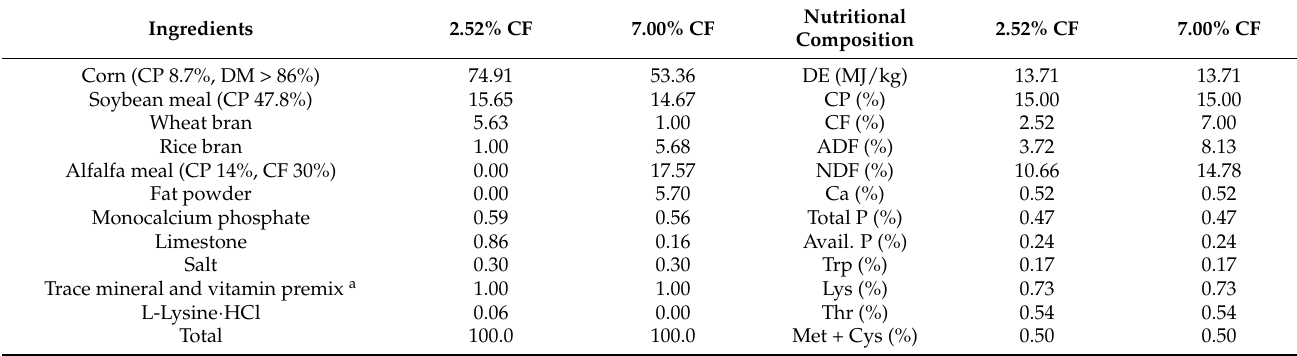
Table 1. Composition of experimental diets (based on dry matter,